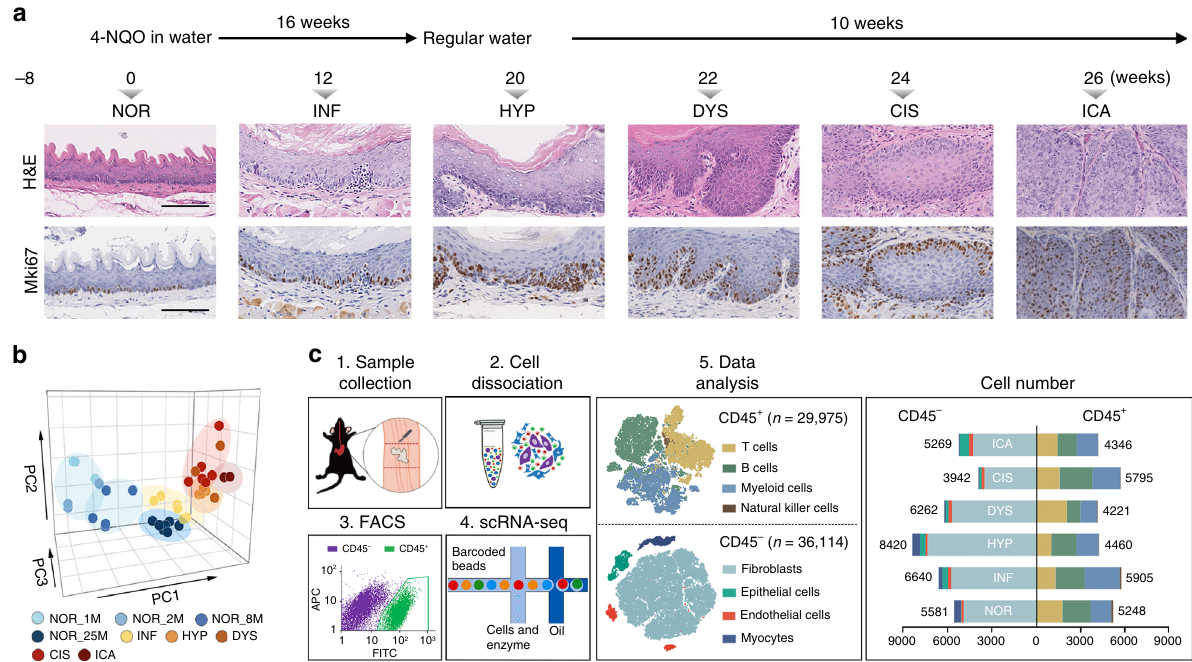
Fig. 1 Experimental design of RNA-seq on 4NQO-induced esophageal lesions in mice. a Induction of esophageal precancerous and cancerous lesions in mice. Mice were treated with 4NQO in drinking water (100 μ g/ml) for 16 weeks and then kept without 4NQO treatment for another 10 weeks (upper panel). Mice were killed before (week 0), during (week 12) and after treatment (weeks 20, 22, 24, or 26), respectively. Hematoxylin – eosin (H&E) staining and immunohistochemistry (IHC) analysis of Mki67 on esophageal epithelium slides clearly identi fi ed six different pathological lesions, i.e., normal (NOR), in fl ammation (INF), hyperplasia (HYP), dysplasia (DYS), carcinoma in situ (CIS), and invasive carcinoma (ICA) (lower panel). Similar staining results were observed in over three visual fi elds from each stage of esophageal lesions (more staining image in Supplementary Fig. 2d). Scale bar, 100 μ m. b Plot of principal component analysis (PCA) of mini-bulk tissue RNA-seq on different pathological lesions indicated by different colors. M month of mouse age. c Overview of the experimental design of scRNA-seq. Pathological lesions of the esophagus were dissected and digested into single-cell suspensions for further separation using FITC-CD45 antibody via FACS (1 – 4). CD45 + and CD45 − cells whose numbers in different lesions are shown on right panel were scRNA-sequenced,